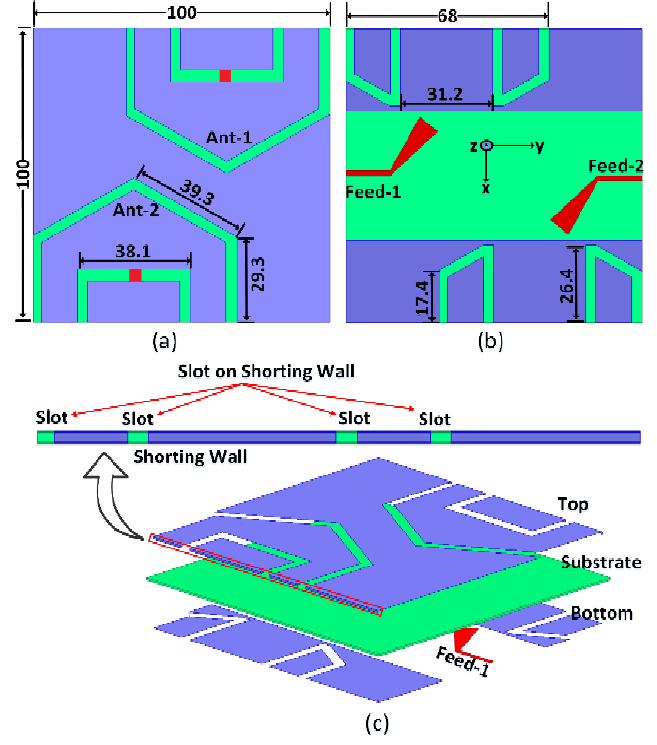
Figure 2. Proposed antenna: ( a ) top view, ( b ) bottom view, ( c ) detail of various antenna layers.